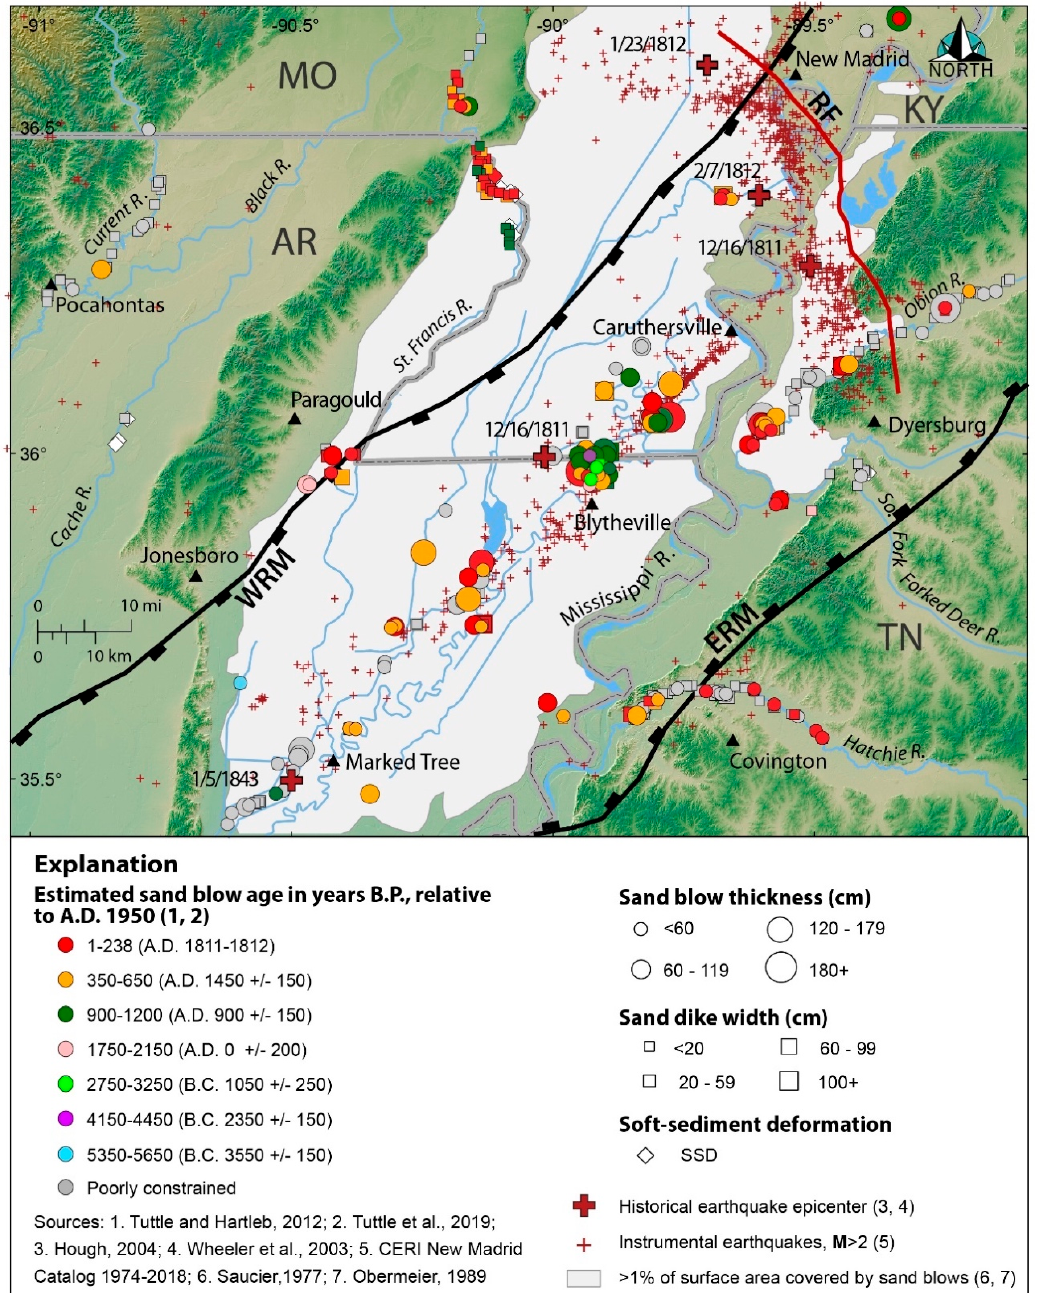
Figure 27. Map of NMSZ (defined by small red crosses), historical earthquakes epicenters [110,212], and surrounding region showing ages and measured sizes of studied liquefaction features (from Reference [8], after Reference [51]), mapped surface area of sand blows [209,213], and geologic structures including Reelfoot fault (RF) and Eastern and Western Reelfoot Rift margins (ERM and WRM).